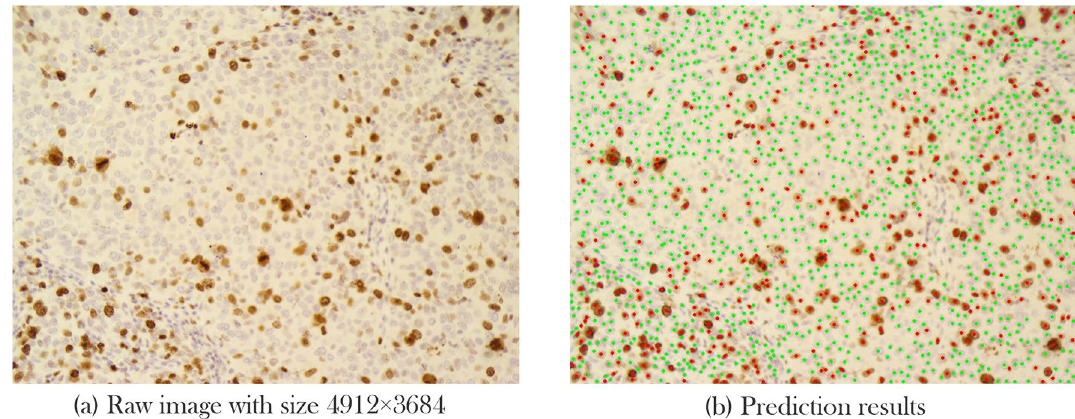
Figure 10. Aggregated sub-image qualitative results. Input raw image is cropped into smaller sub-images and, after prediction, aggregates to build the input image. This sample is visualized from the test